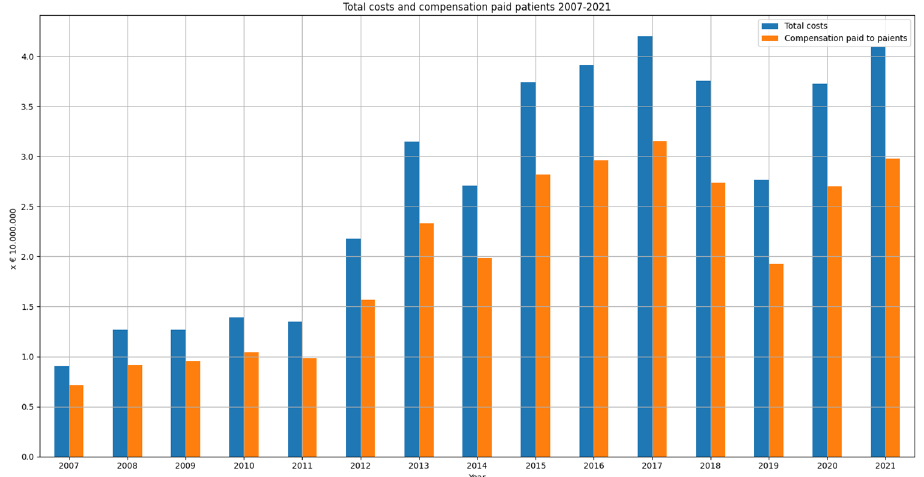
Figure 7. Total costs and compensation paid to the patients (closing year 2007–2021).